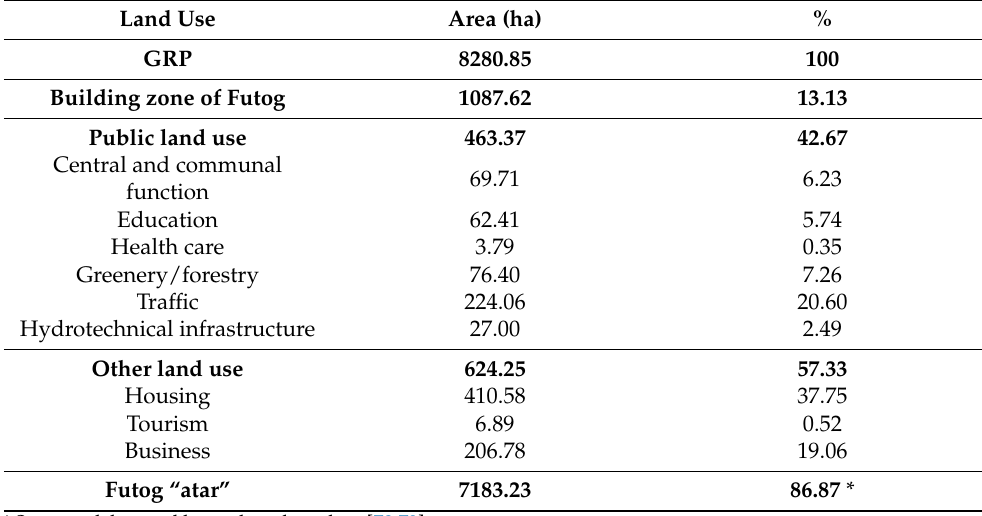
Table 2. Planed land use balance for the Futog settlement